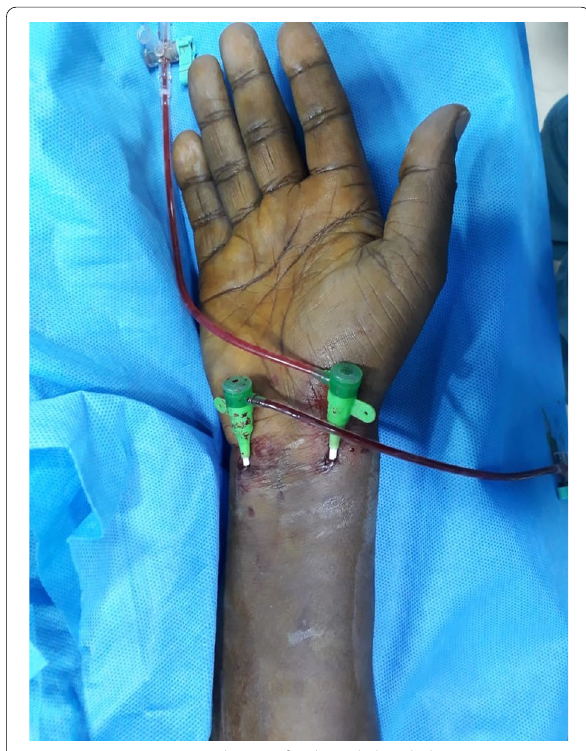
Fig. 1 Concurrent cannulation of right radial and ulnar artery in a patient undergoing coronary intervention using 16-cm-long 6F hydrophilic coated introducer sheaths in right radial and ulnar artery (Glidesheath ™ , Terumo medical corp, NJ,